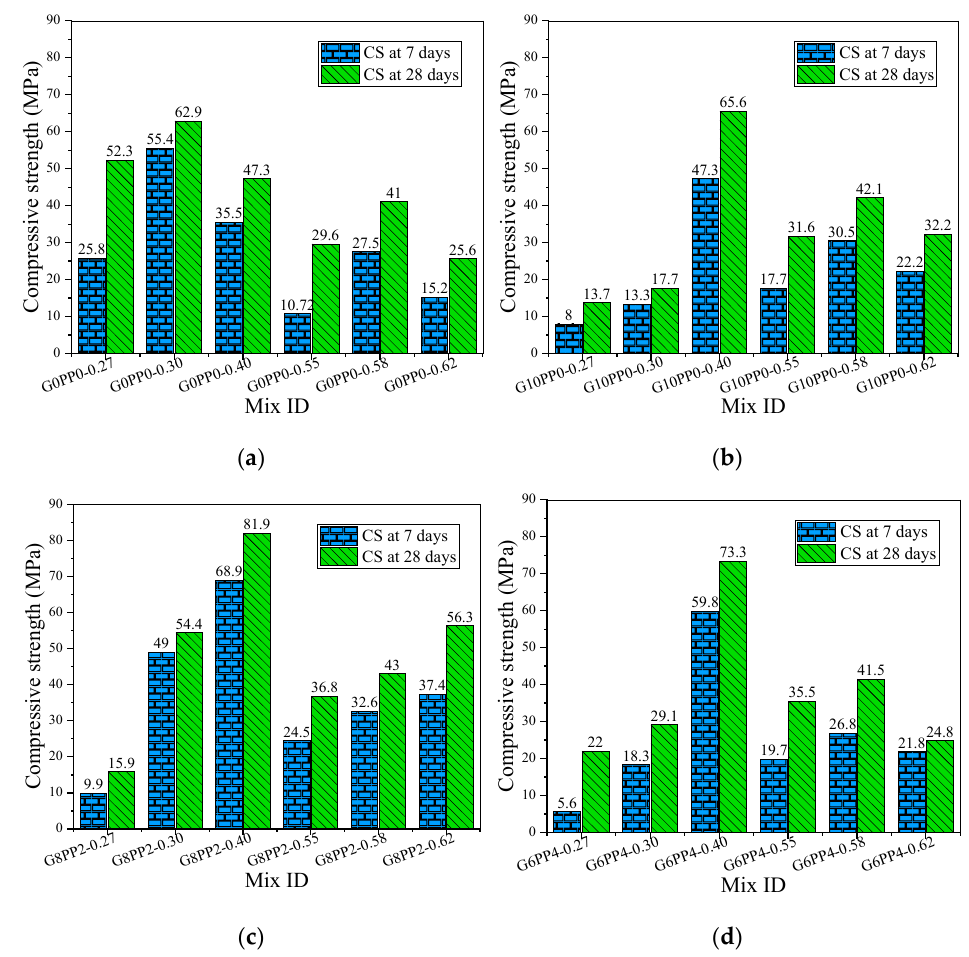
Figure 2. Compressive strength of mortar: ( a ) The compressive strength of mortar in group 1; ( b ) The compressive strength of mortar in group 2; ( c ) The compressive strength of mortar in group 3; ( d ) The compressive strength of mortar in group 4.